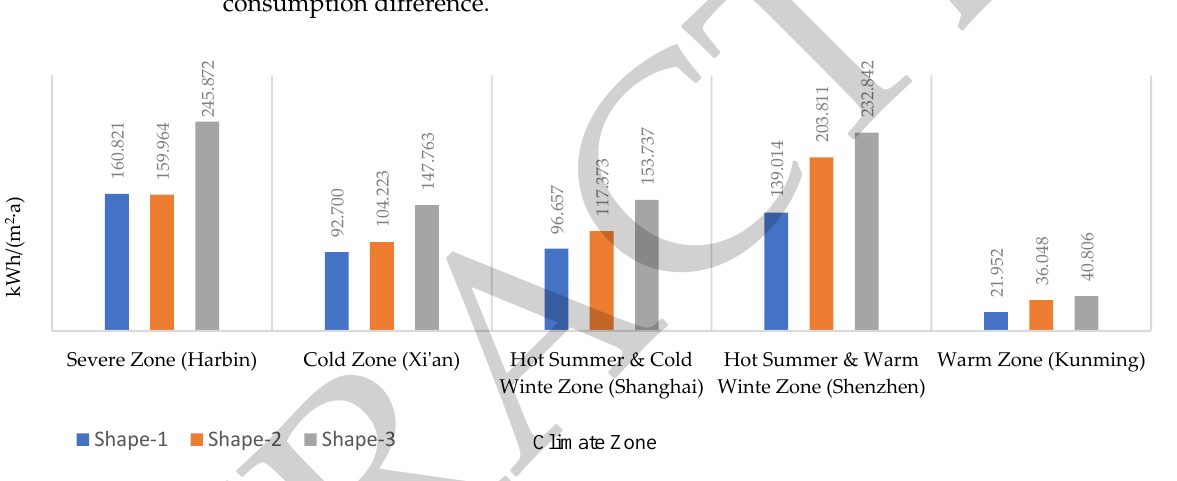
Figure 8. Comparison of simulation results of three typical models in five climate zones.